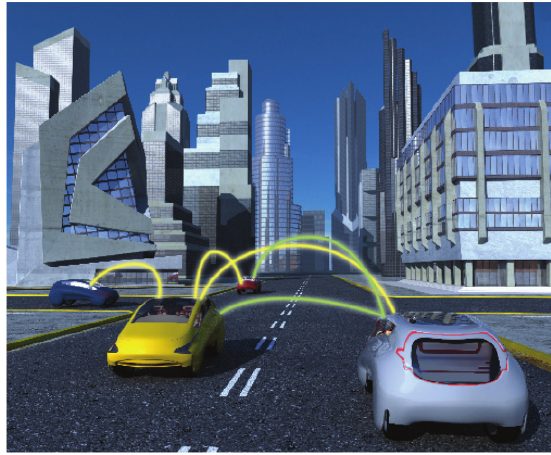
Figure 6. Autonomous vehicles connected through a smart urban mobility